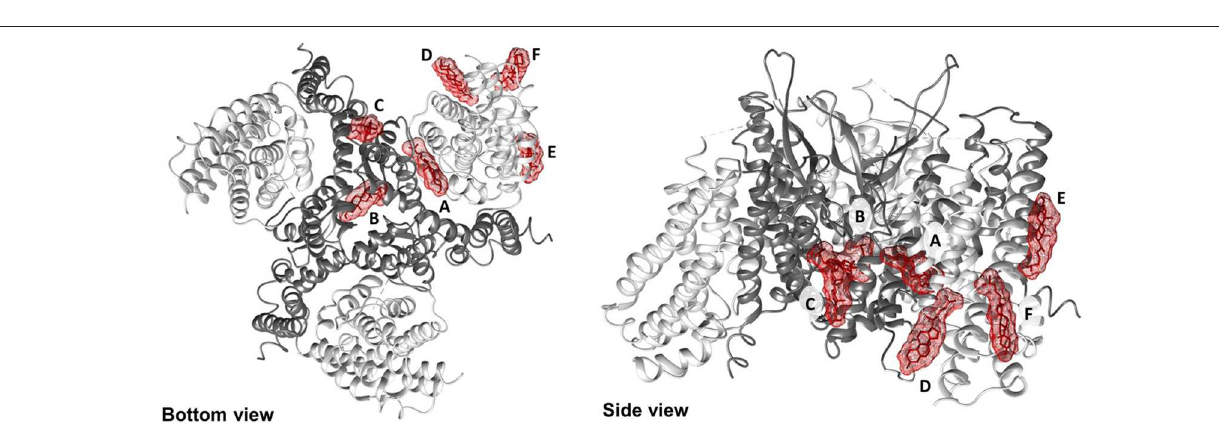
FIGURE 5 | Docking of cholesterol molecules with hASCT2. Bottom view (left) and side view (right) of the trimeric hASCT2 (PDB: 6GCT). Cholesterol molecules, indicated by letters A, B, C, D, E, and F are depicted as red sticks with mesh surface interacting with the scaffold domain (TMs 1,2,4,5 in dark gray ribbon) and with the transport domain (TMs 3,6,7,8, HP1 and HP2 in the light gray ribbon) of a protomer. The numbering of TMs corresponds to those described in Figure 4 . Dotted gray lines indicate missing residues in the 3D structure (PDB: 6GCT). The structure was visualized using Chimera 1.13.1